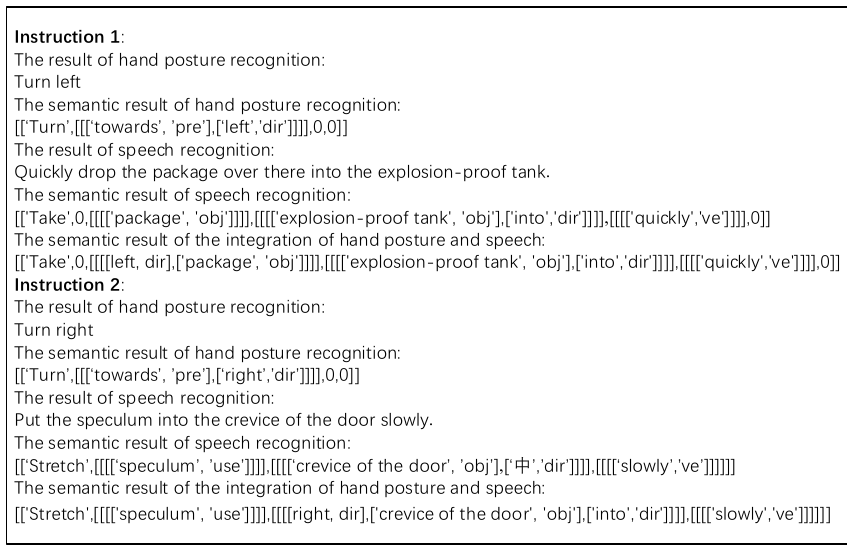
Figure 19. Results of the integration of deictic hand posture and spoken instructions when the demonstrative word was an adjective.